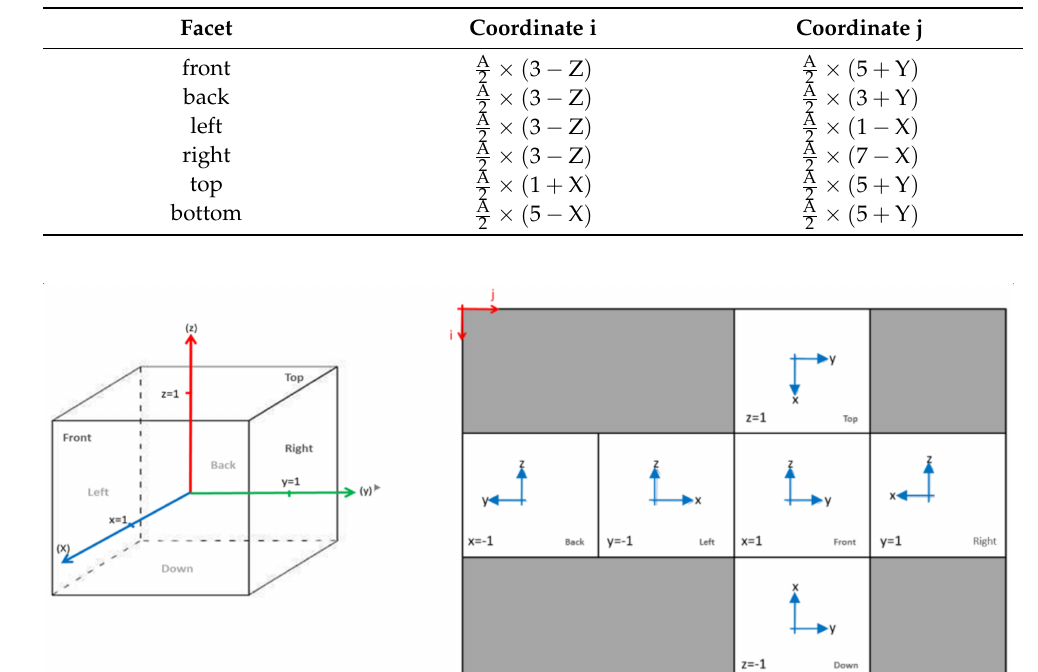
Table 1. Image coordinates of the cubemap facets.